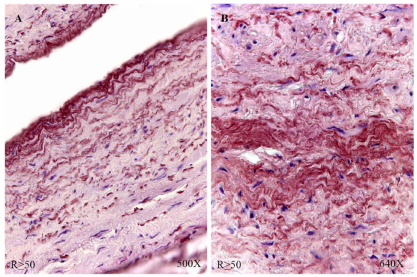
Figure 5. Images showing the elastic fibers in patients with R ≥ 50 ( A , B ). 3.2. Patients with Venous Reflux Show Increased Expression of Tropoelastin Tropoelastin gene expression analysis showed a statistically significant increase in R patients (NR = 59.129 ± 14.655, R = 122.576 ± 54.530, * p < 0.05, Figure 6). A sig-